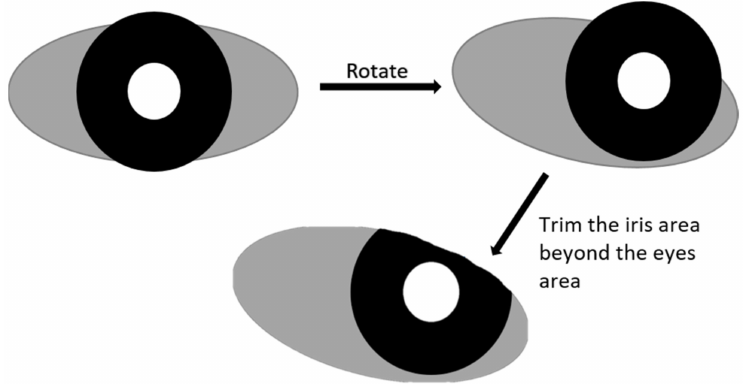
Figure 5. The process of automatic mask generation.